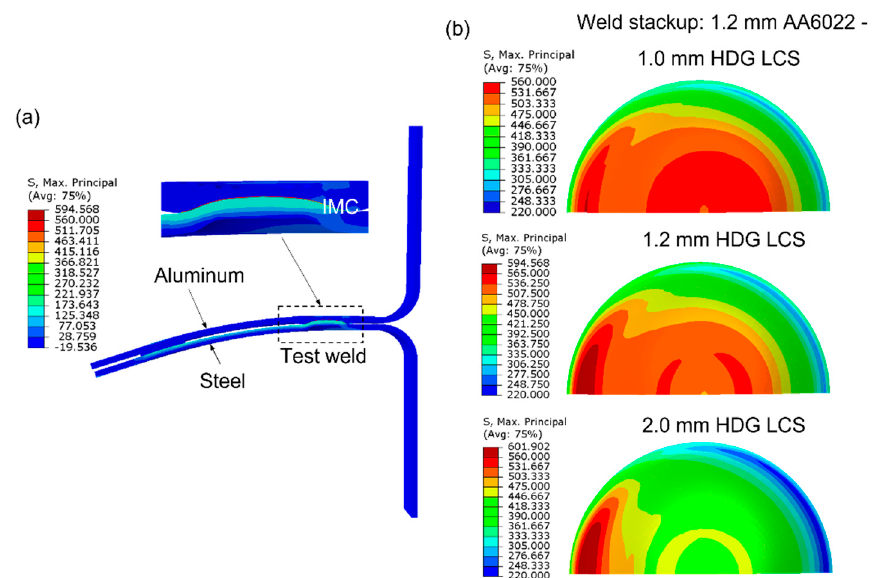
Figure 6. Numerical results of ( a ) thermal stress distribution in a double joint RSW specimen and ( b ) the variation of thermal stress in IMC layer with increased thickness of steel plate under baking process.